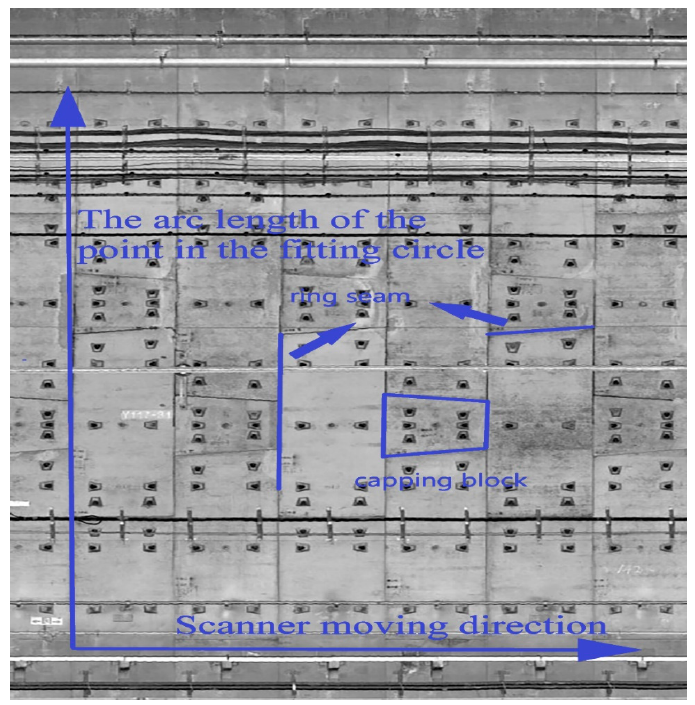
Figure 5. Orthophoto generation effect.